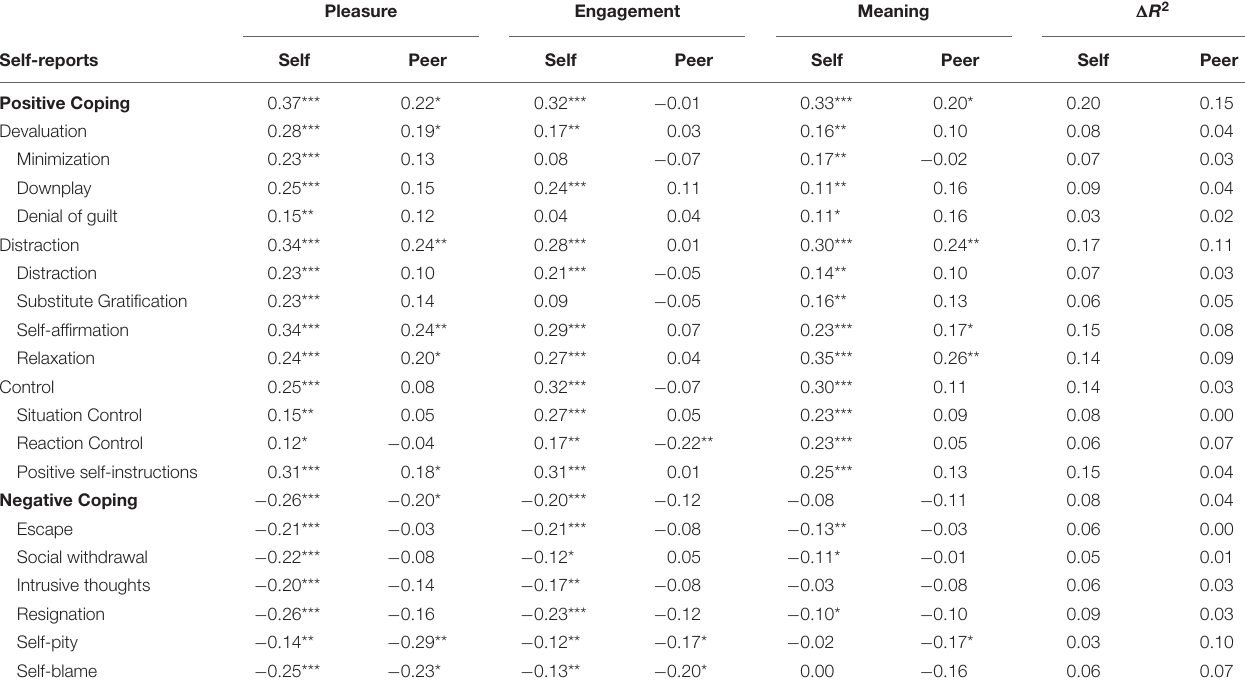
TABLE 3 | Correlations between self- and peer-reported orientations to happiness and positive and negative coping strategies (controlled for age and gender). Pleasure Engagement Meaning (cid:49) R